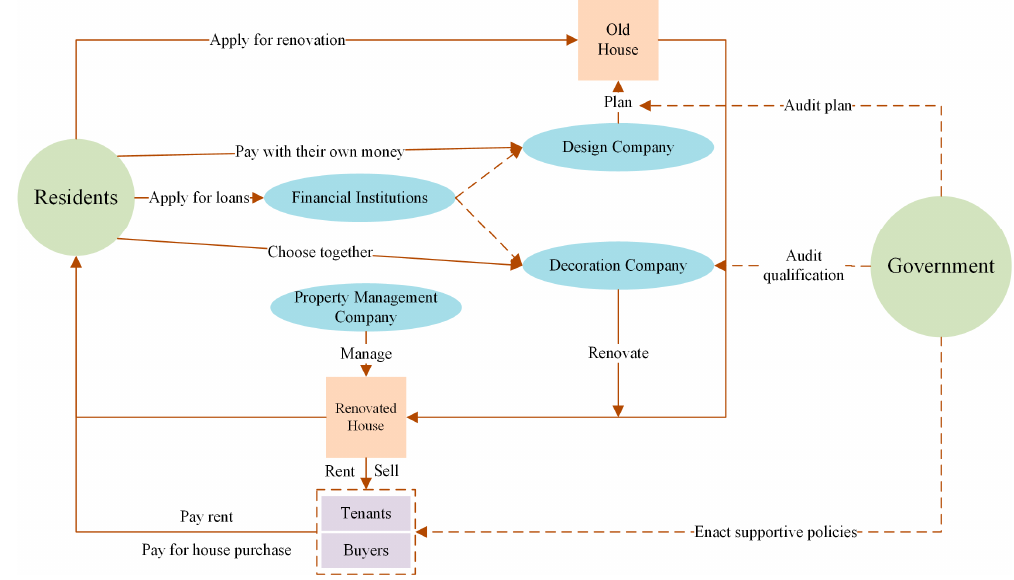
Figure 5. The platform for multi-stakeholder engagement in housing conservation and renovation. Measure 5: Degressive subsidies